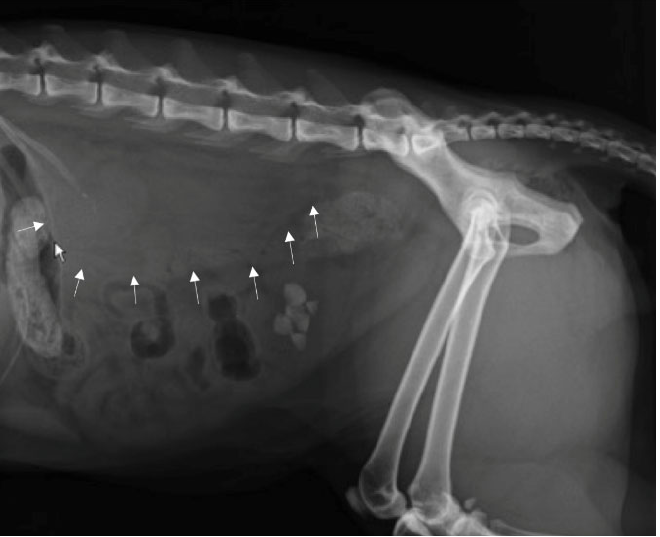
Figure 1. Lateral radiograph of the abdomen: loss of contrast in the lumbar region (arrows) and a presence of uroliths in urinary bladder.